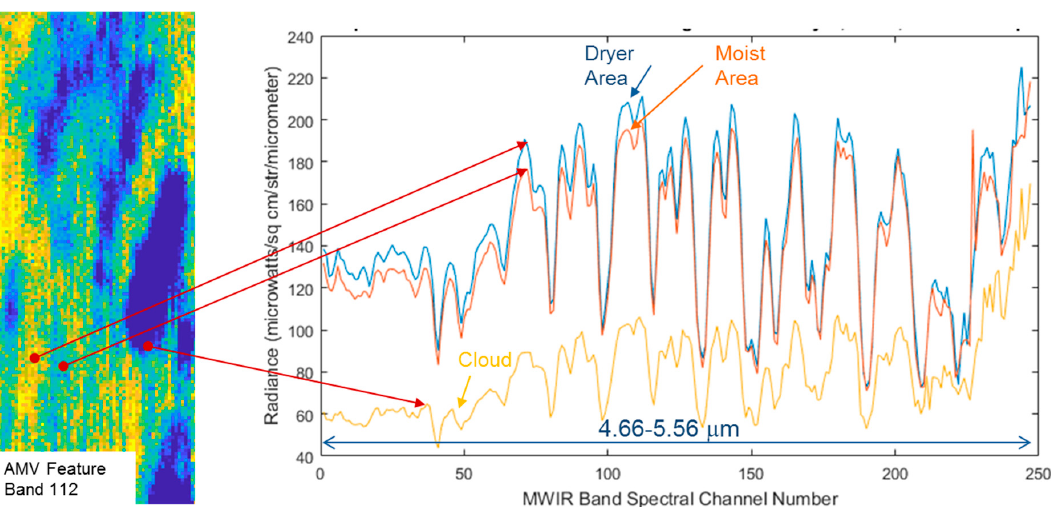
Figure 13. Spectra for a portion of the radiance image (for channel 112, near 5.068 µ m) near a cloud feature used for cloud-motion-vector observation. The radiance contrast in the image ( left ) has been expanded and shifted to show the higher brightness temperature of the water vapor field which surrounds the cloud. The brightest regions in the image are those without cloud and with low water vapor concentration. The spectra shown ( right ) are 10 × 10 pixel averages in the cloud, moist air, and dry air regions (surface emission-dominated) areas in the